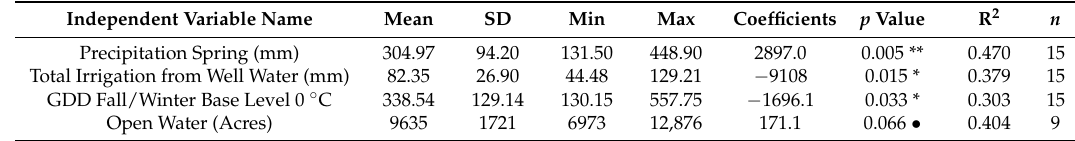
Table 1. The linear regression analysis between significant variables and annual nitrate flux ( n =